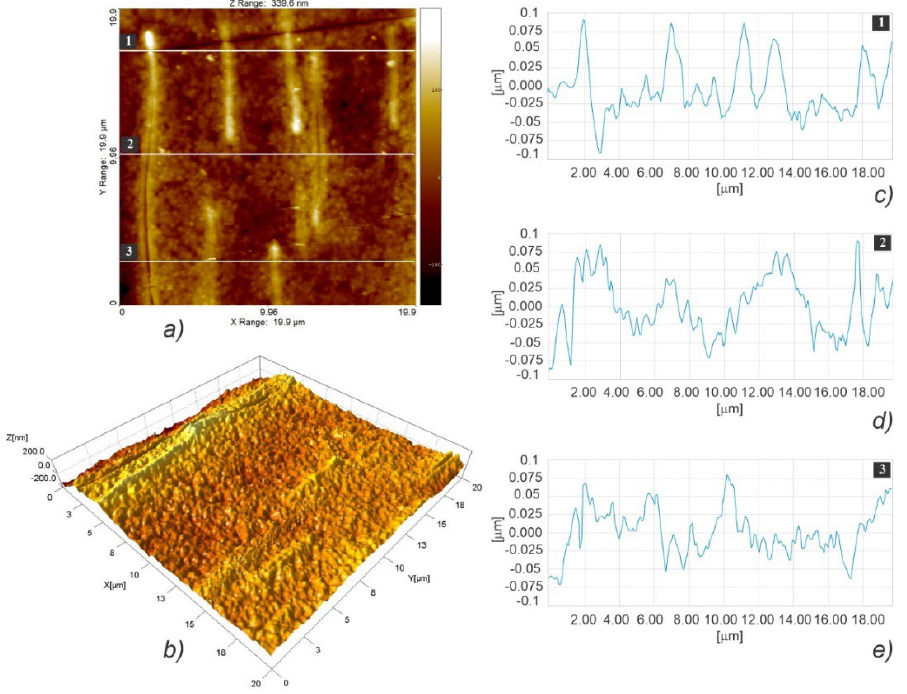
Figure 12. AFM topographic images obtained for the HLC scaffold over 20 × 20 µm area ( a , b ), and the corresponding profiles taken at locations marked with 1 ( c ), 2 ( d ), and 3 ( e ).